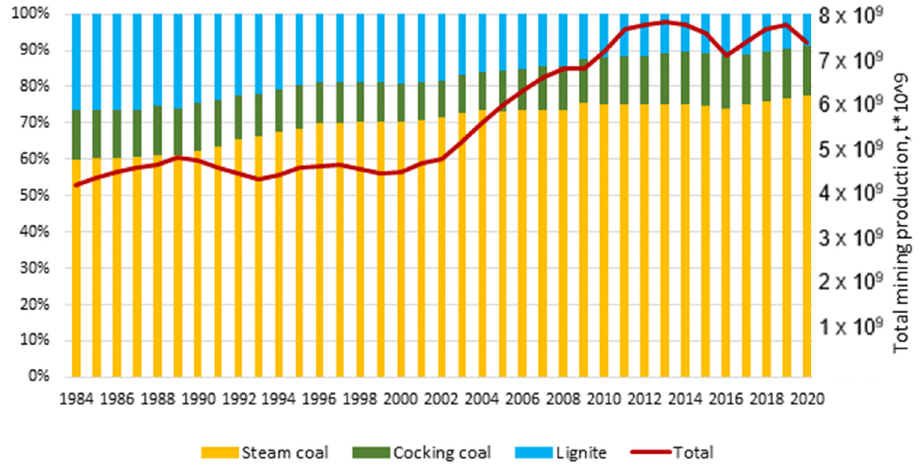
Figure 1. Mining production of main types of coal in the period 1984–2020 [1]. It should also be pointed out that world coal consumption can be described as a steady but increasing trend, analyzing the time period of the recent four decades. This is also linked with a number of various research projects on coal and a number of scientific publications, as mentioned in the following section. Figure 1 presents the trend of the world production of coal over the last four